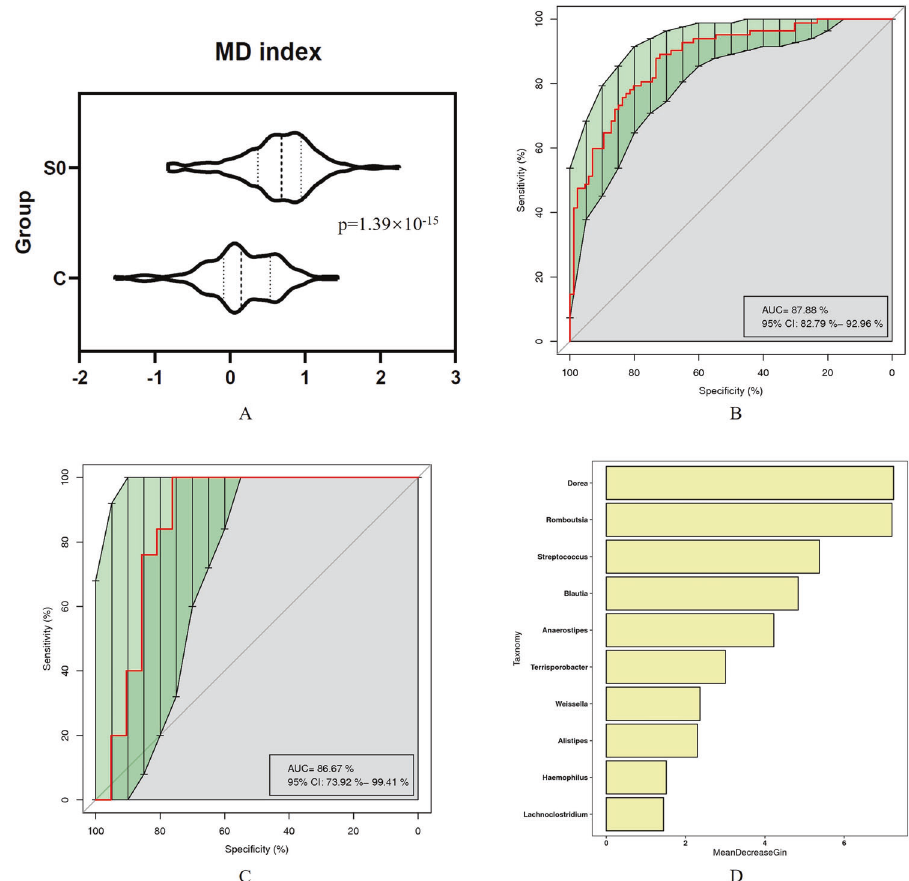
Fig. 3 Alteration of microbial biomarkers in SCH patients. A Comparison of MD index between SCH patients and HCs. B and C prediction models for discovery samples B and testing samples C . D The 10 microbial biomarkers in descending order of Gini coef fi cient. S0: SCH patients, C: healthy controls. FDR were used to correct the multiple